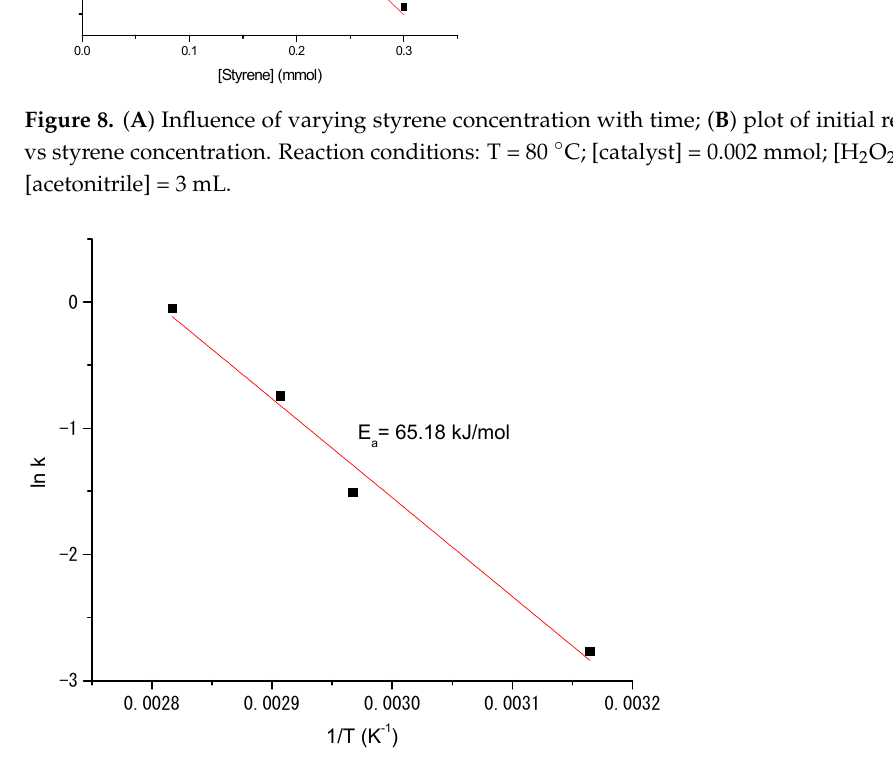
Figure 9. Arrhenius plot of the pseudo-first-order rate kinetic constants for styrene oxidation.